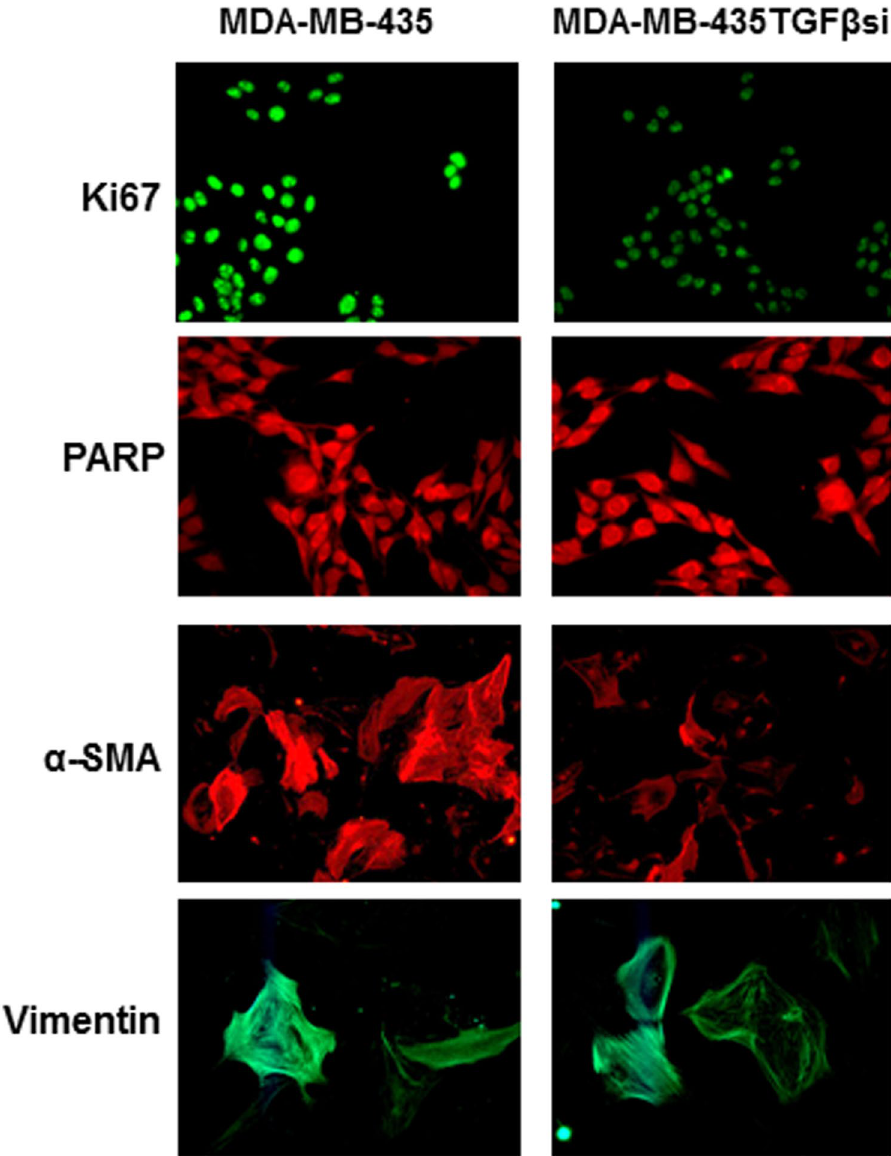
Figure 5. Co-culture assays to determine the effects of paracrine signaling on stromal cell proliferation, apoptosis and fibroblast differentiation. Fibroblasts were cultured in conditioned medium from MDA-MB-435 or MDA-MB-435-TGF β si cells for 72 hrs. From replicate cultures, cell proliferation was determined using Ki67 staining and apoptosis determined using PARP-p85 staining. To determine myofibroblast differentiation cells were stained with alpha-smooth muscle actin ( α -SMA). Vimentin staining was performed as a control for the mesenchymal cell lineage. Images were captured using a Leica fluorescence microscope